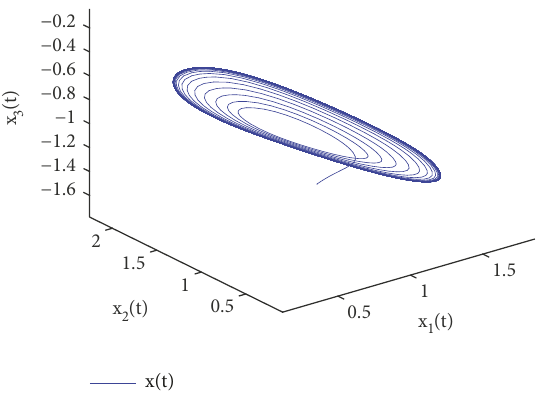
Figure 1: Phase plot of master system with initial condition 𝑥(0) = (1.1,1.3, −1.5) 𝑇 .